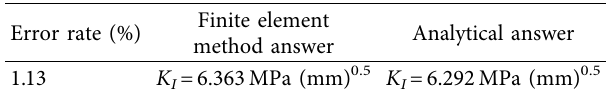
Table 10: Comparing the results for plate including central crack. Error rate